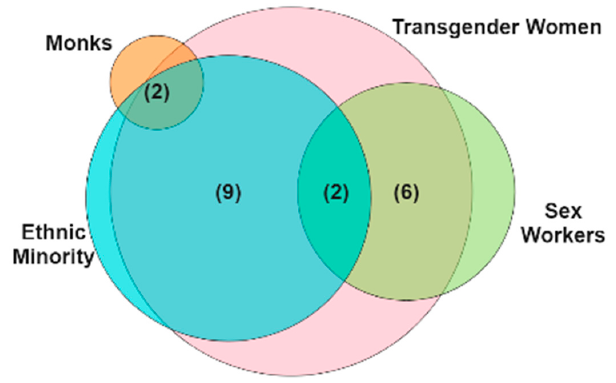
Figure 1. The number of participants with an intersectional identity (n).